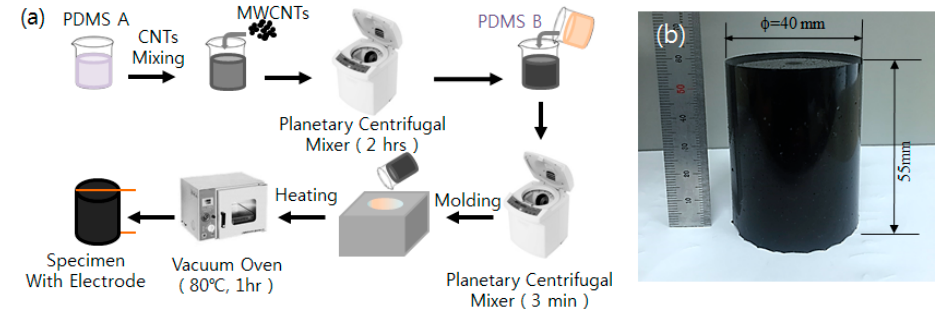
Figure 2. CNT/PDMS composite sample: ( a ) fabrication process and ( b ) photograph.